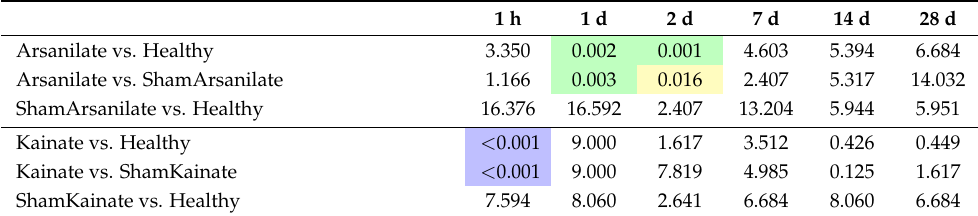
Table A3. Bonferroni-corrected p values for fraction of the sphere visited during movement (one-sided Mann–Whitney U test; p values lower than 0.05, 0.01 and 0.001 are highlighted in yellow, green and blue, respectively).